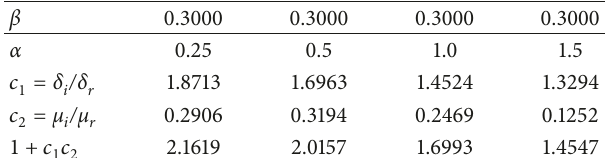
Table 2: Numerical values of the coefficients c (27) for four values of α and β � 0 . 3.